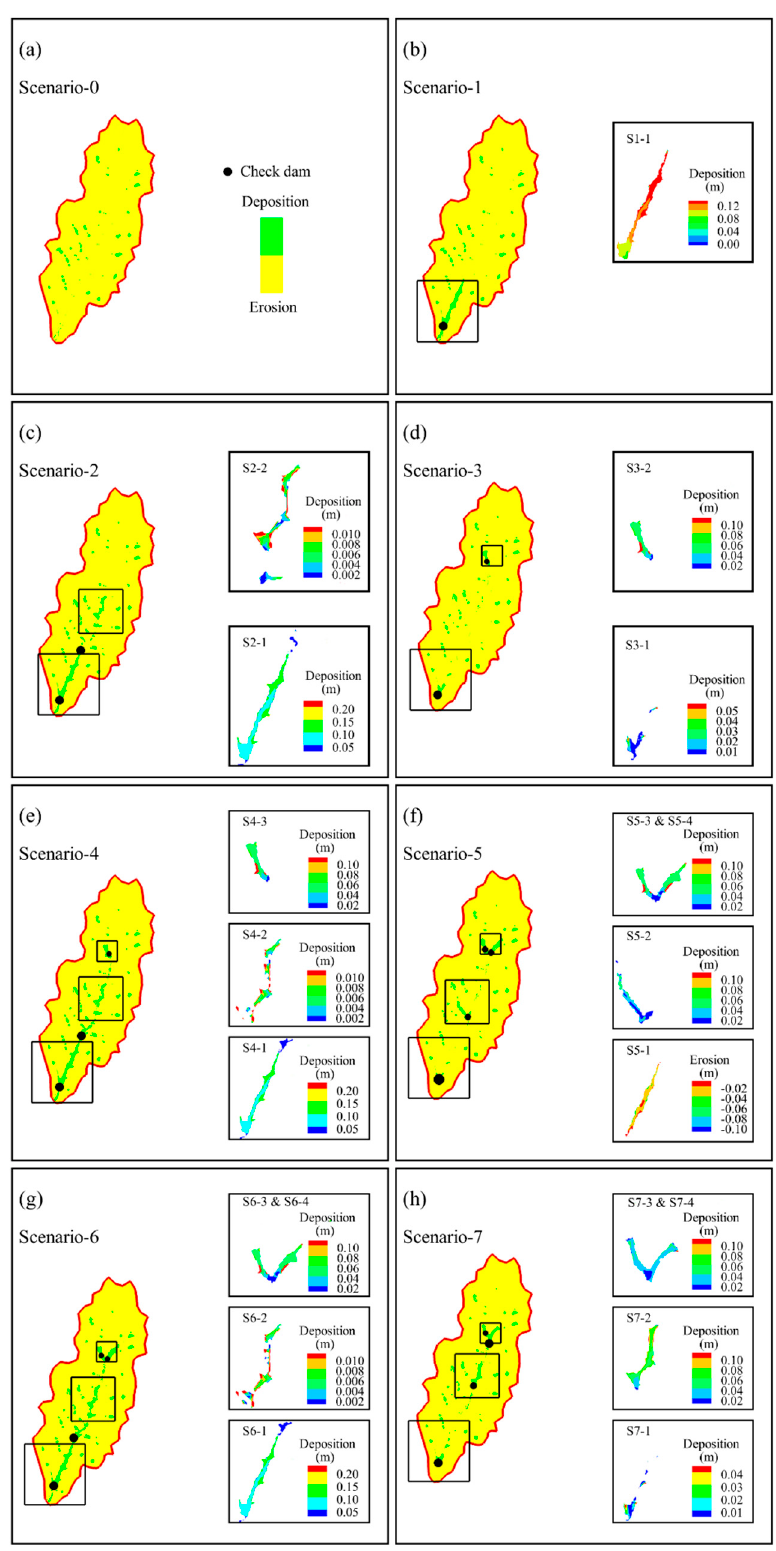
Figure 7. The final distributions of erosion and deposition areas in scenario-0 ( a ); scenario-1 ( b ); scenario-2 ( c ); scenario-3 ( d ); scenario-4 ( e ); scenario-5 ( f ); scenario-6 ( g ); and scenario-7 ( h ). Note that the inset pictures in each figure show the deposition depths on the sedimentary lands, and the areas with deposition depth below zero (i.e., erosion) were blanked for the consideration of readability.